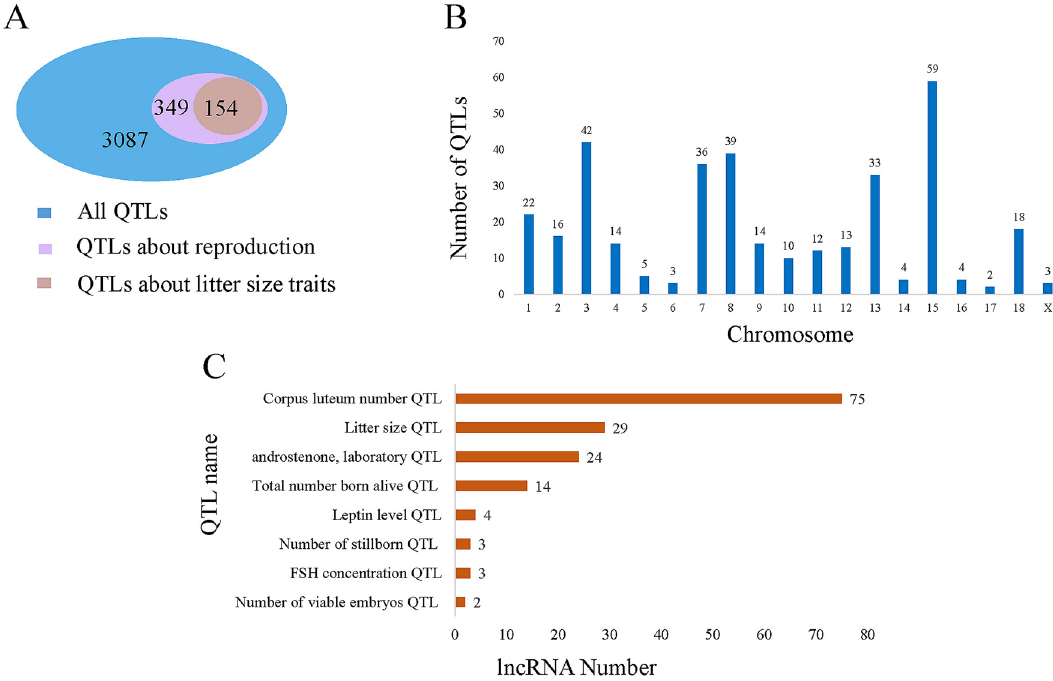
Figure 4. QTLs analysis of DELs. ( A ) The number distribution of QTLs associated with reproduction and all of the QTLs. ( B ) The chromosome distribution of QTLs associated with reproduction. ( C ) The lncRNA number of QTLs associated with reproduction